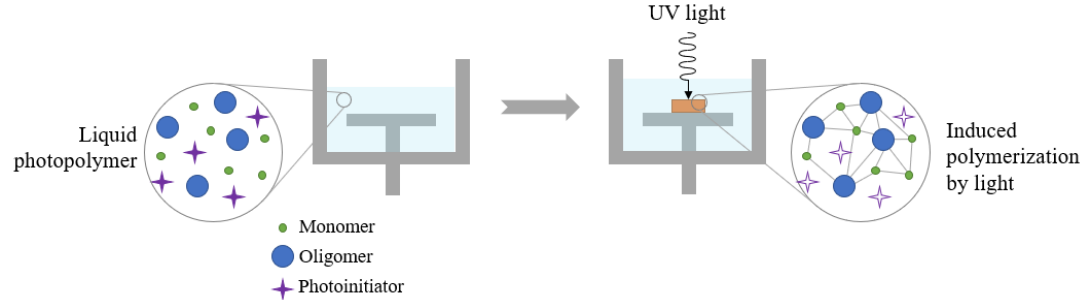
Figure 3. Example of a mixture that undergoes cross-linking when exposed to light.